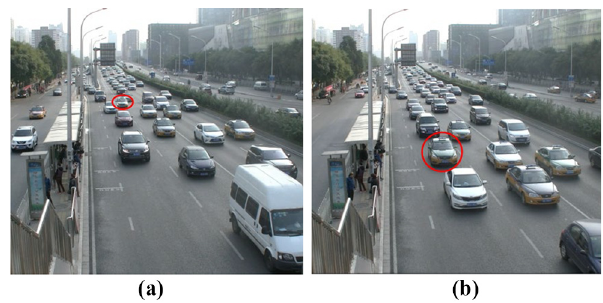
Figure 8 Traf fi c situation in the weaving area after changing lanes in